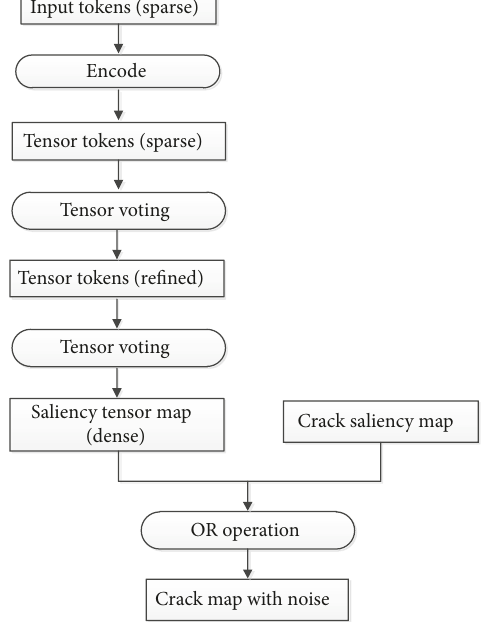
Figure 8: Overall TV approach.